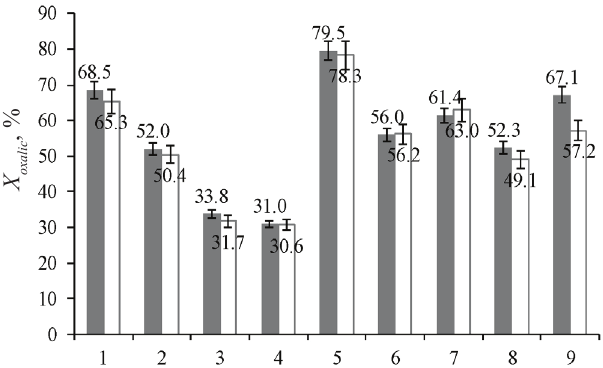
Fig. 3 – Comparison of the average yields of oxalic acid ox- idation achieved after 120 minutes treatment of UV/TiO cess in BRa (UVA, (1) – (4)), BRb (UVC, (5) – (8)) and after 4 cycles in CSTR (9). Reacting mixtures were: (1), (5) OX, (2), (6) OX + MY10, (3), (7) OX + RV2, (4) – (9) OX + MY10 + RV2 (DAW). Dark and white columns denote extents achieved using P25 and PC-500,